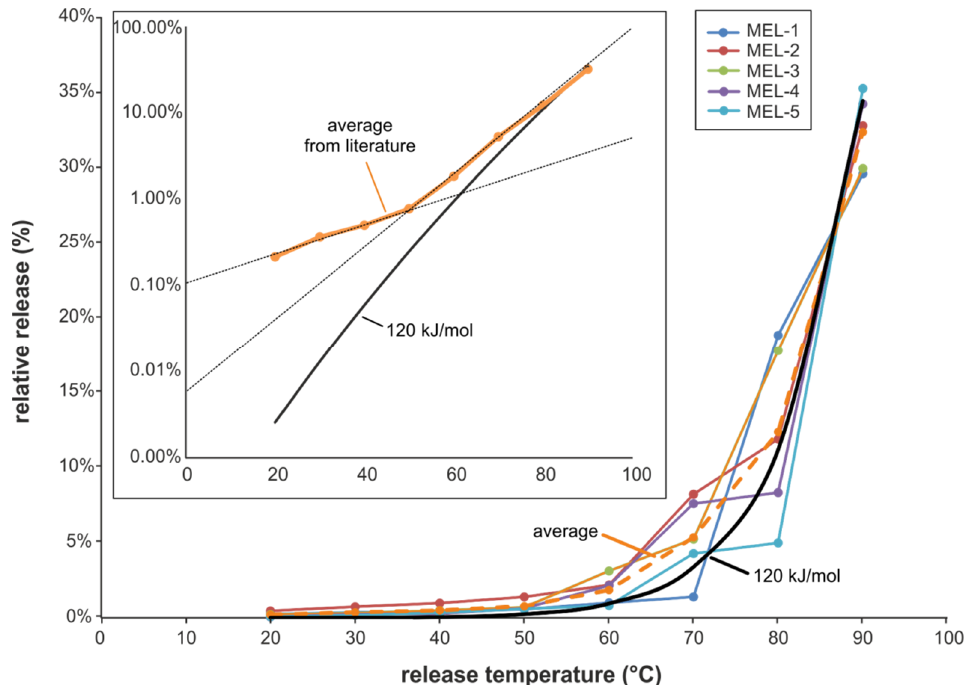
Figure 6. Comparison of literature data [10] on temperature dependence of melamine migration/decomposition (5 different cups, MEL-1 to MEL-5) with the results of this work; dashed broad line (orange): average of the published data, solid broad line (black): this work, calculated values for an activation energy of 120 kJ/mol. Inset: logarithmic scale.